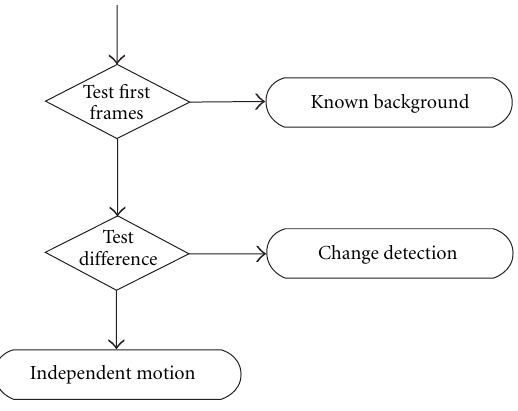
Figure 1: The tests of image sequence